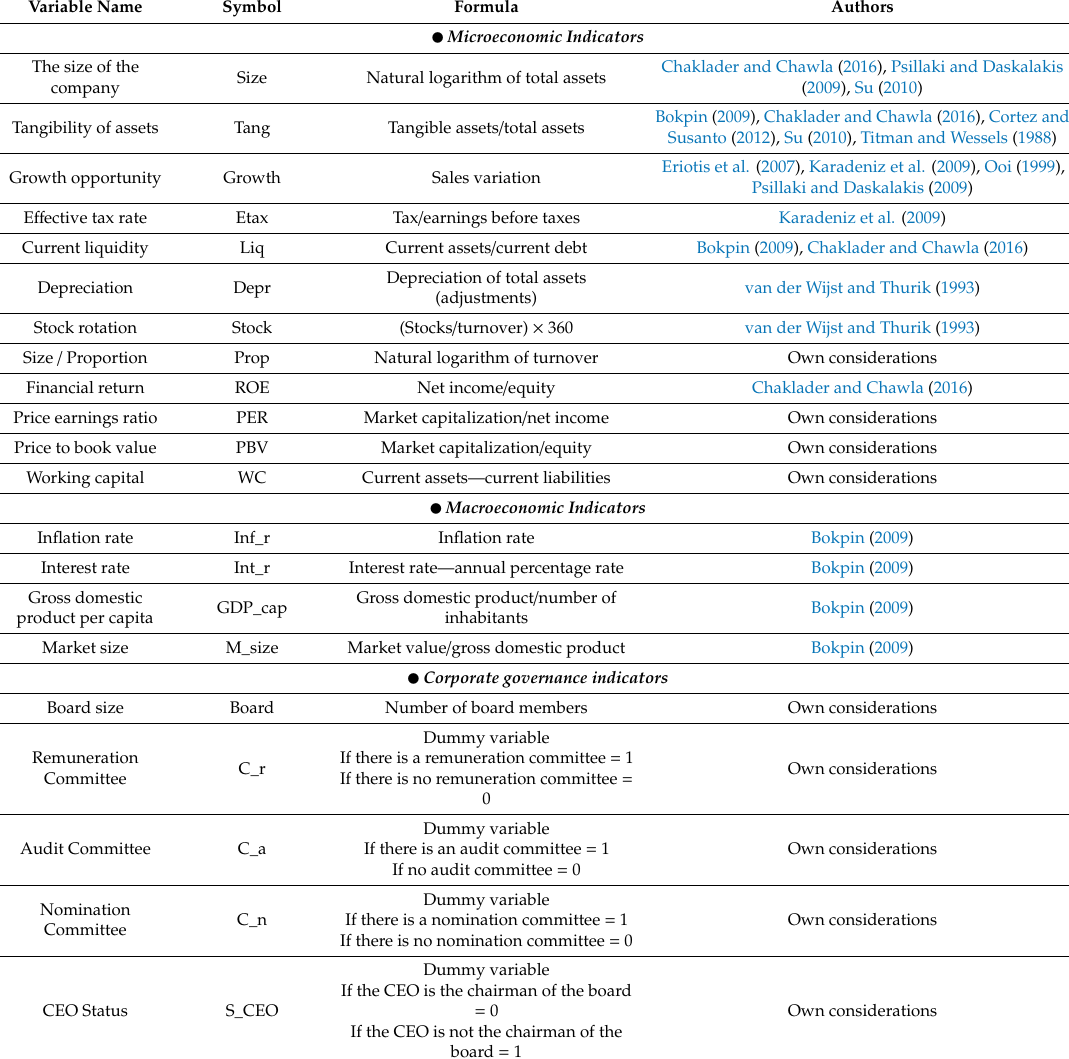
Table 2. Independent variables included in the empirical